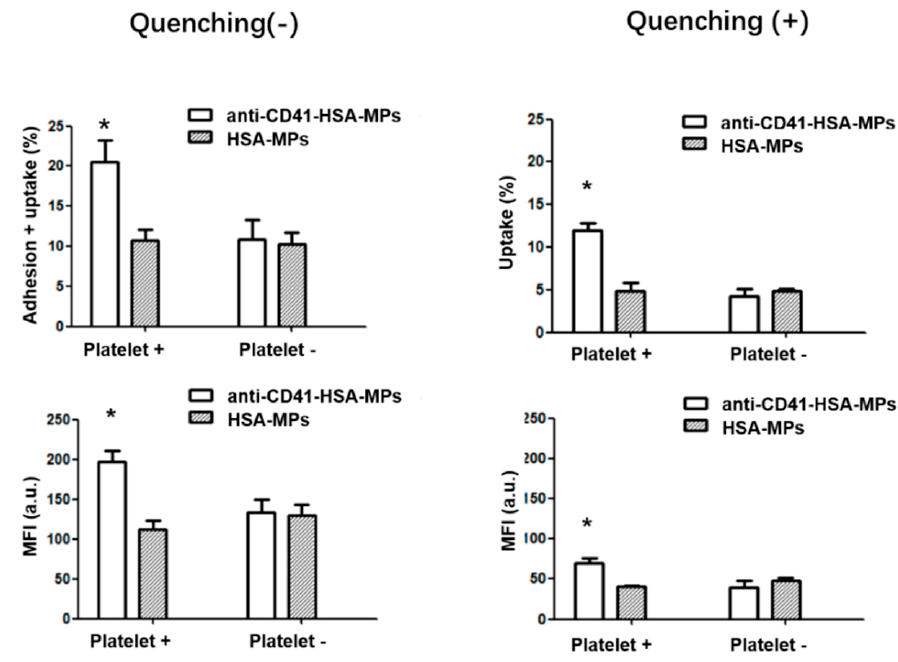
Figure 4. Adhesion vs. cellular uptake of anti-CD41-HSA-MPs and HSA-MPs in A549 cells analyzed by flow cytometry with or without pre-incubation with activated platelets. Adhering particles are excluded by quenching with Trypan blue. The upper graphs show the percentage of events in the A549 cell population with enhanced fluorescence in the FITC channel. The lower graphs show the corresponding Mean Fluorescence Intensities. * p < 0.05.